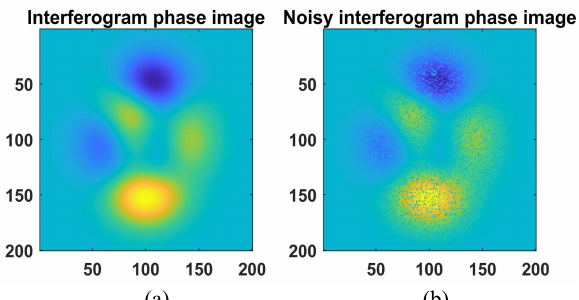
Figure 3. Interferogram without noises (a) and without